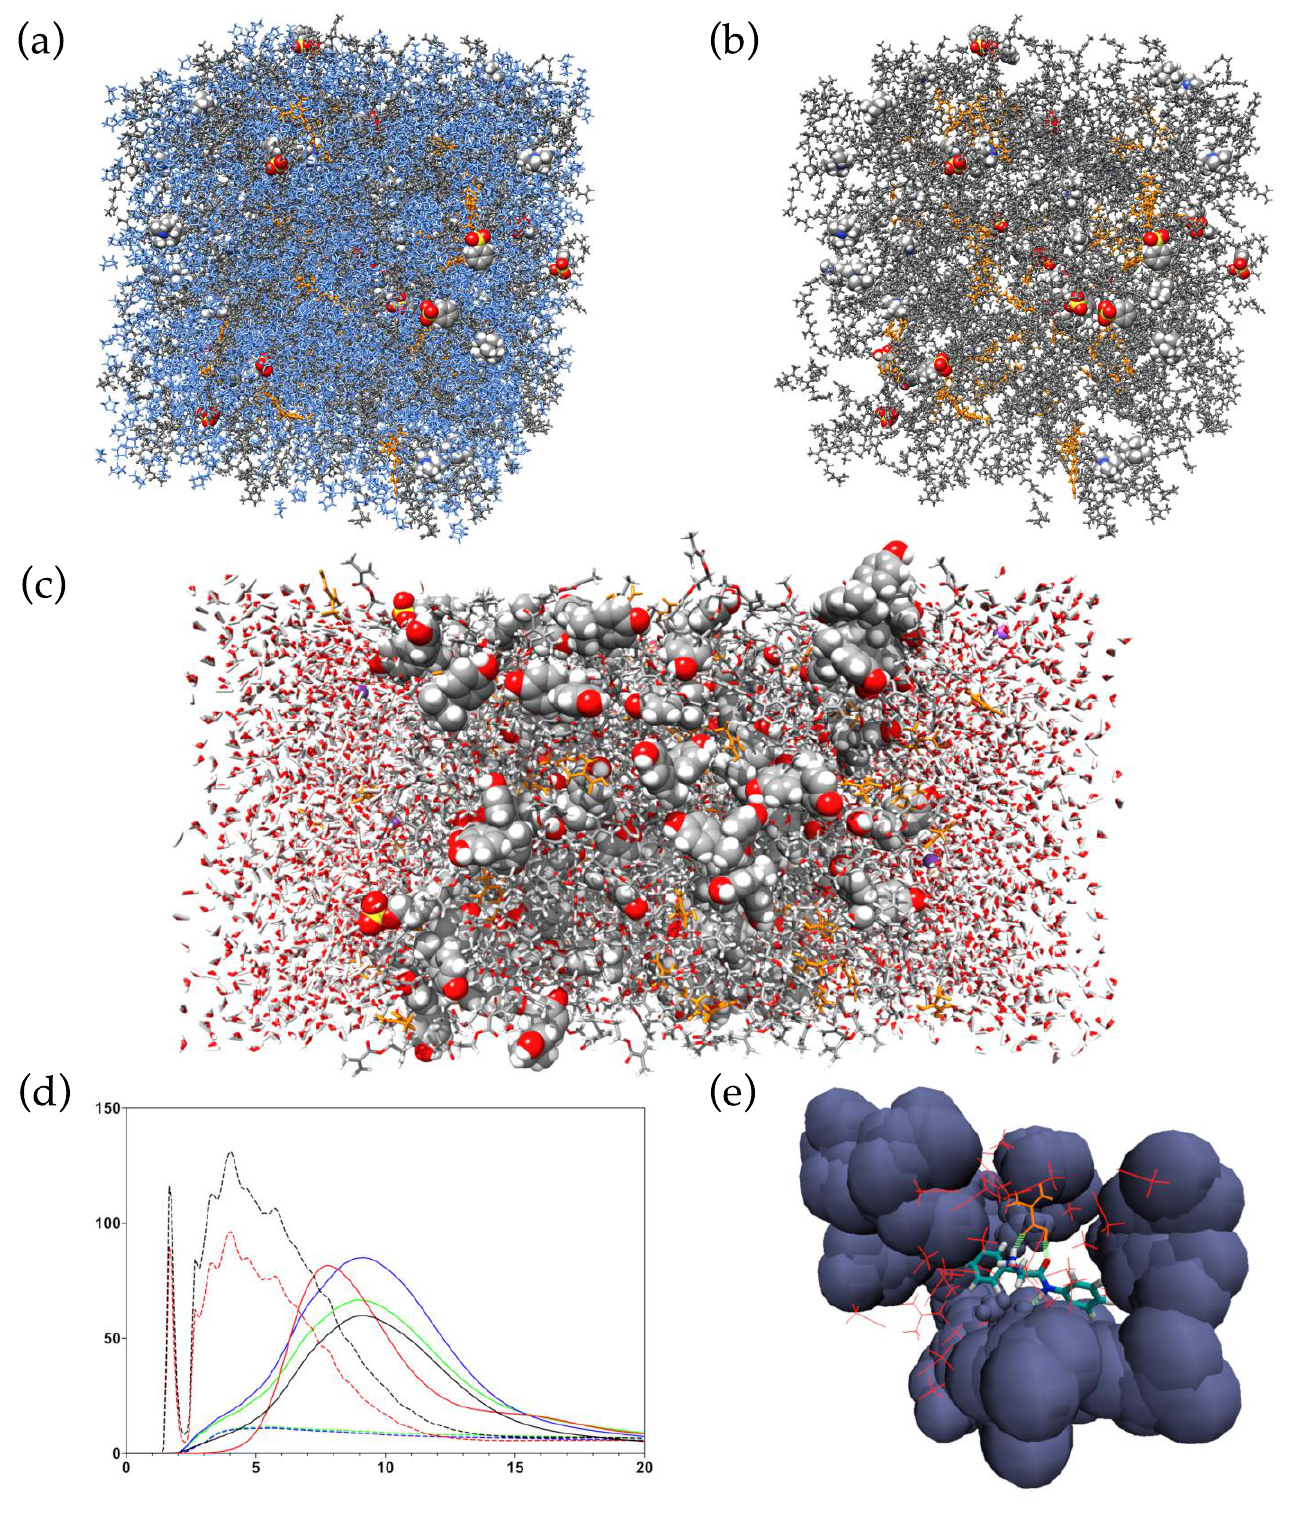
Figure 3. Examples of MD simulation systems and MD data-derived analysis methods. ( a ) Full-system all-atom MD simulation of urea-based MIP anion receptors [89]. ( b ) The same system though excluding solvent (tetrahydrofuran) from visualization. ( c ) Two-phase water bisphenol A MIP emulsion polymerization simulation [90], where polymer components are flanked by aqueous phase with dissolved counter ions. ( d ) Radial distribution function analyses for component interactions [89] . ( e ) Grid density analysis plot, where local densities of interacting species are visualized [20] .